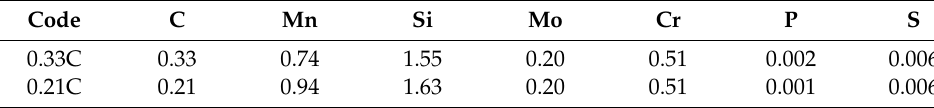
Table 1. Chemical composition of both steels